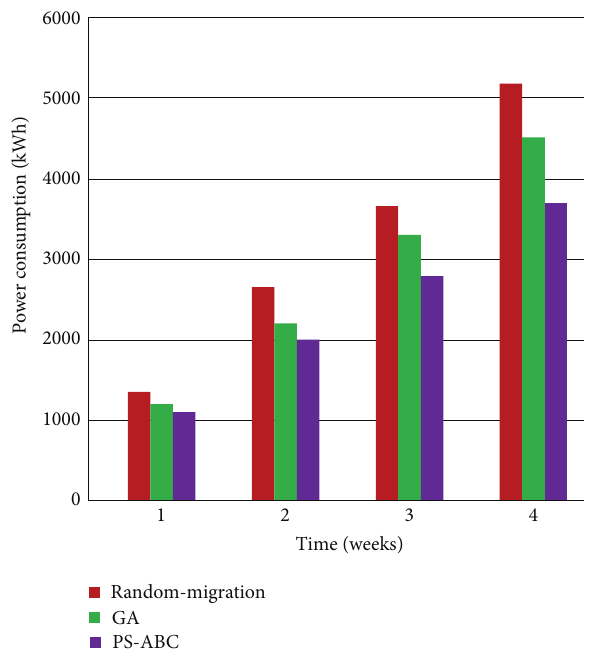
Figure 4: Comparison of GA, Random-Migration, and PS-ABC in power